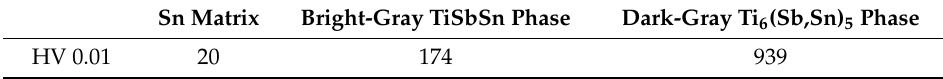
Figure 11 . Representation of measuring points of the Sn5Sb3Ti solder. Table 5 . EDX analysis of the Sn5Sb3Ti solder . Spectrum